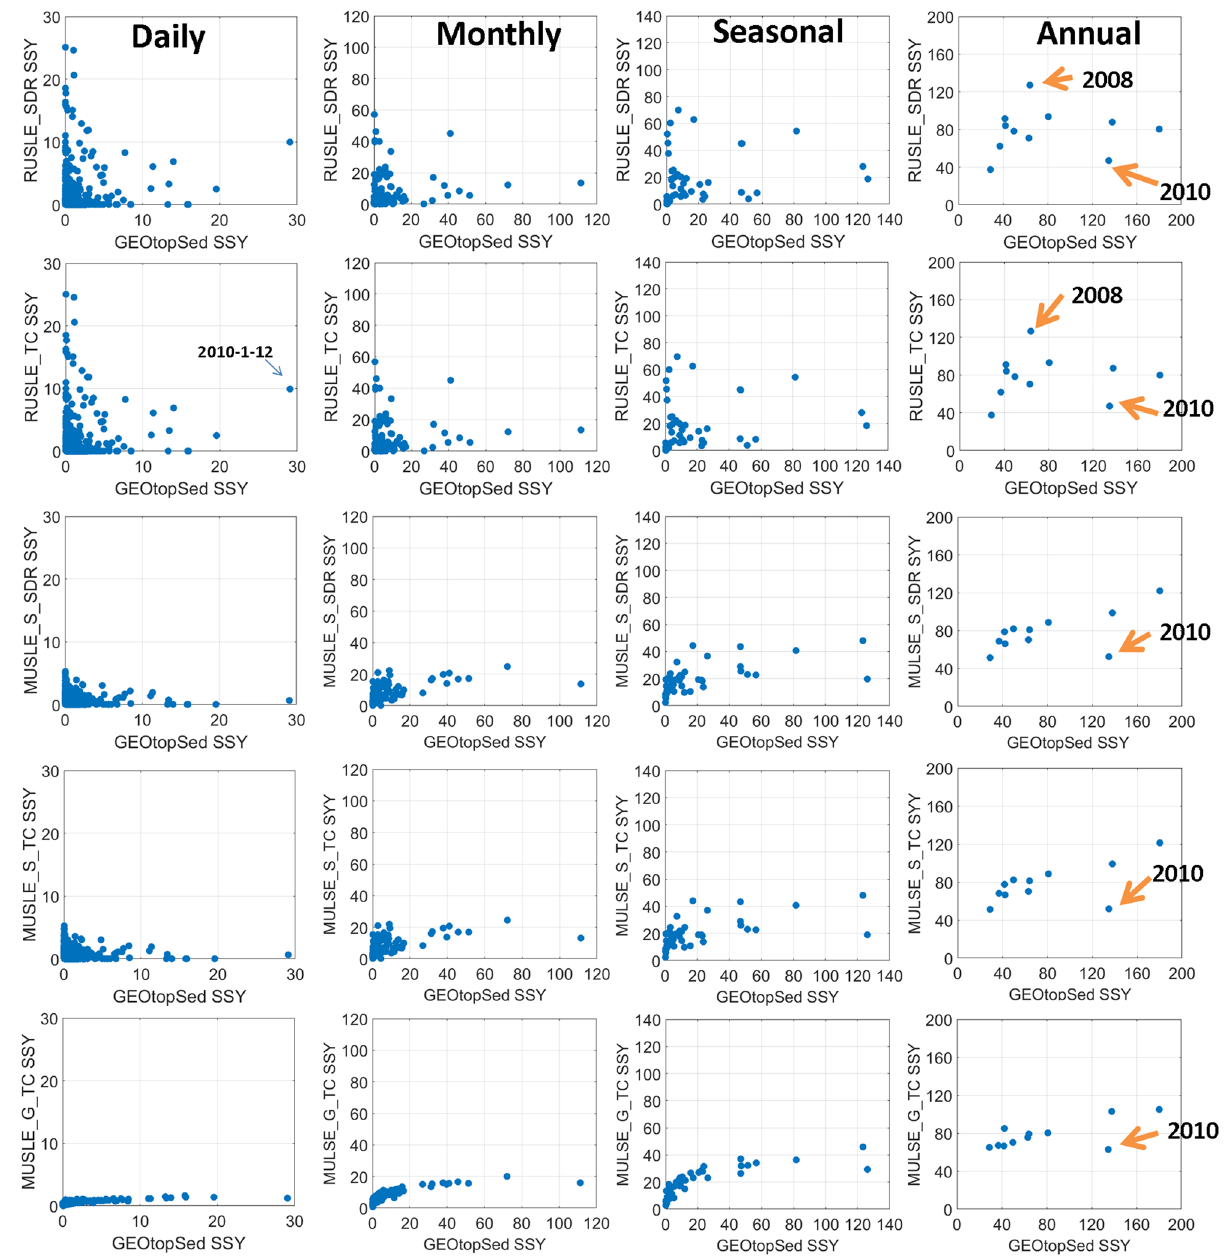
Figure 1. Scatter plots comparing SSY estimates (ton/time interval) between GEOtopSed and five other model configurations at daily, monthly, seasonal, and yearly scales. A zoom-in of individual panels is shown in Supplementary Fig.